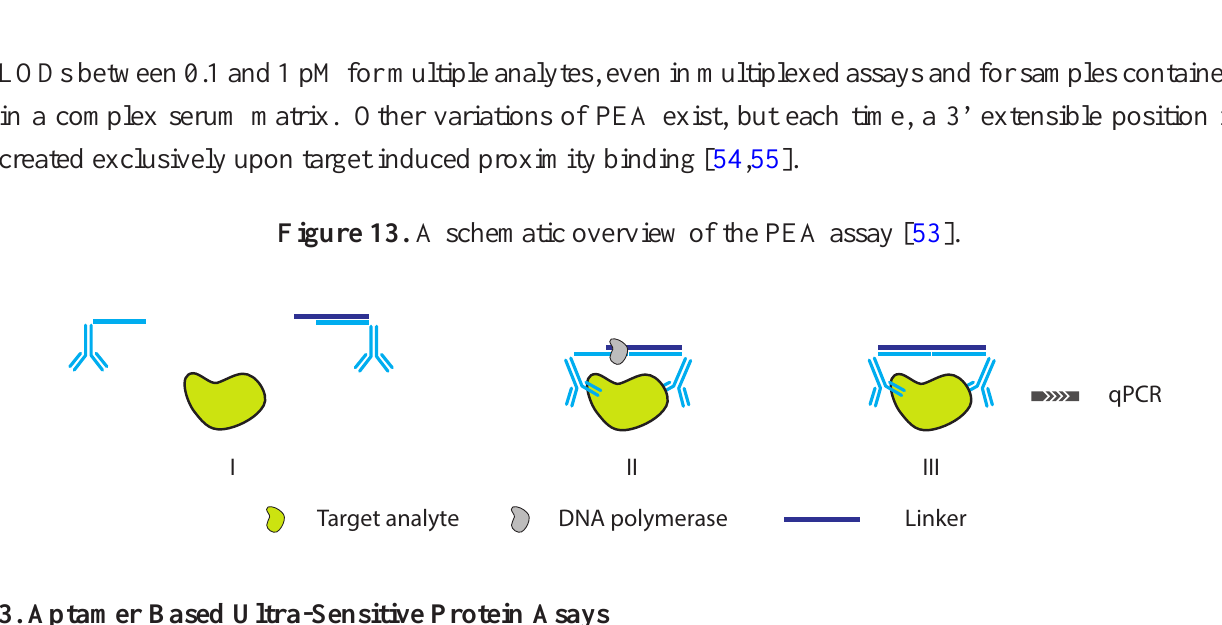
DNA polymeraseTarget